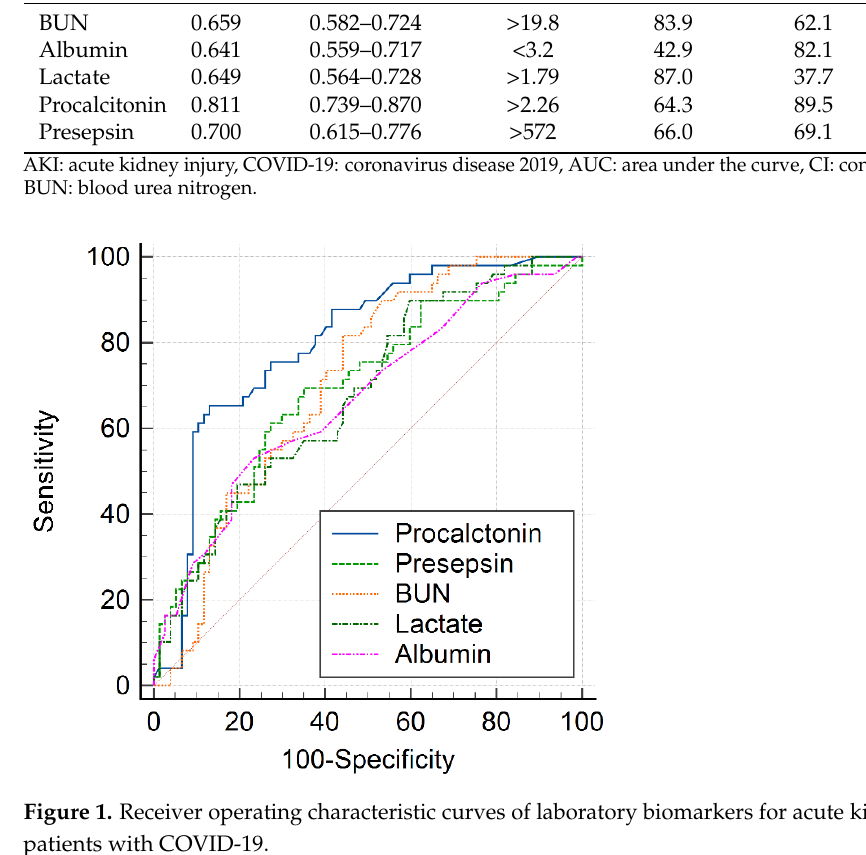
Table 5. Comparison of demographic and clinical characteristics between survivors and non-survi- vors among patients with COVID-19.